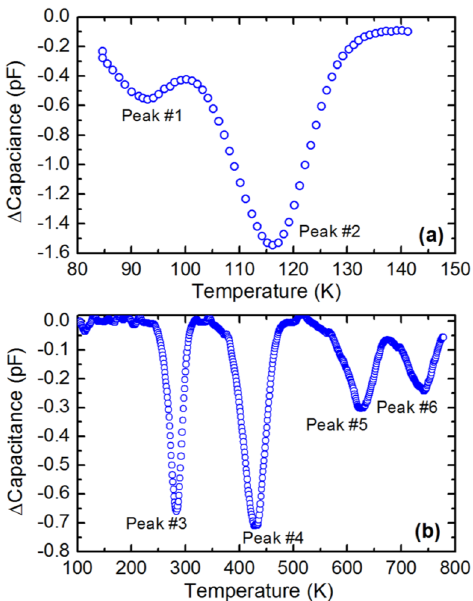
Figure 20. A typical deep level transient spectroscopy (DLTS) spectra obtained using the 50 µ m n-type